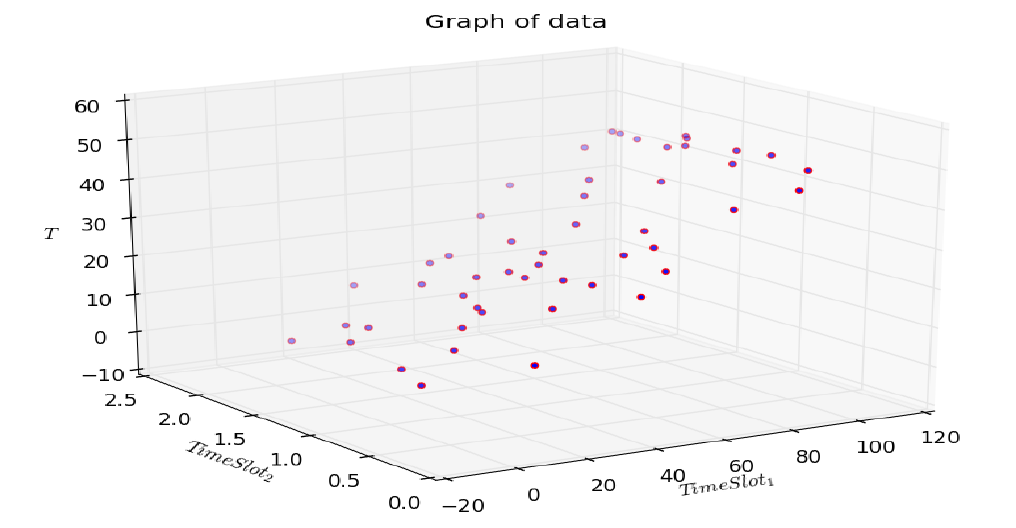
Figure 12. Fitness function value for each